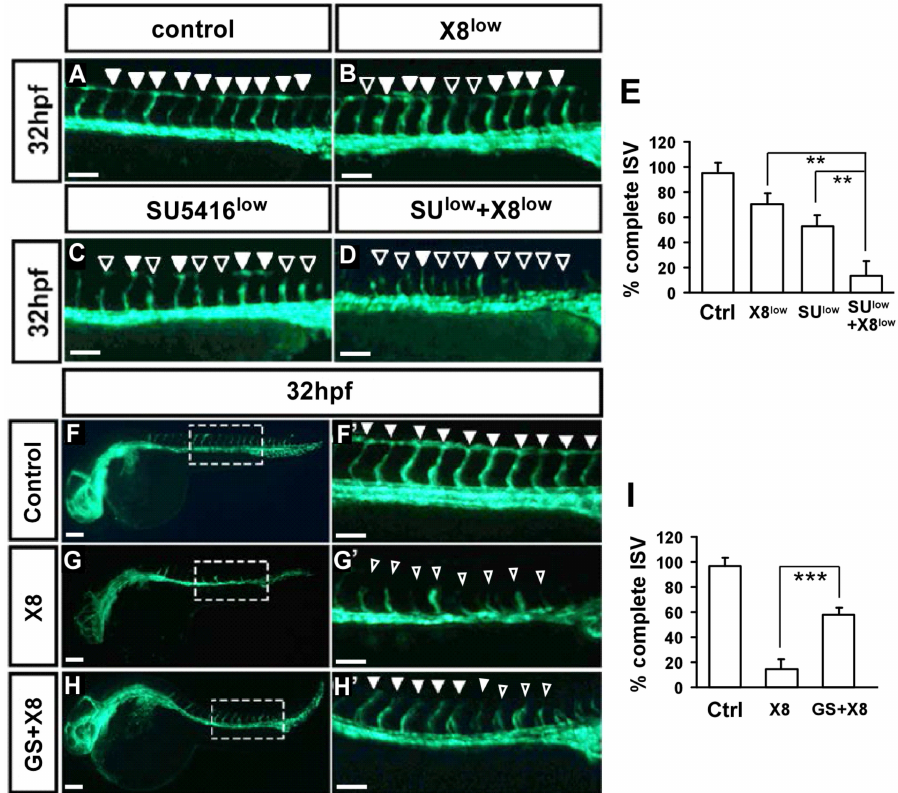
Figure 6. Interaction between X8 and VEGF signaling. ( A – E ) Enhanced effects of vascular defects in embryos cotreated with X8 and SU5416. At 32 hpf, in untreated control embryos ( A ), ISVs reached the DLAV ( arrowheads ). ISV growth was weakly affected in embryos treated with a lower concentration of X8 (1.5 µ M) ( B ) or a lower concentration of SU5416 (5 µ M) ( C ). Embryos treated with the combination of X8 and SU5416 showed enhanced vascular defects in ISV growth (hollow arrowheads in ( D )). ( E ) The quantitative analysis of ISV structures showed an enhanced reduction in X8- and SU5416- cotreated embryos (n = 20) at 32 hpf. ( F – H , F’ – H’ ) Rescue effect of the angiogenic compound GS4012 in X8-treated Tg(flk:egfp) zebrafish embryos. Embryos were treated with X8 (3 µ M) in combination with ( H , H’ ) or without ( G , G’ ) GS4012 (1 µ g/mL) at 6 hpf and were then imaged at 32 hpf. The percentage of complete ISV structures is quantified in ( I ). The data are presented as the mean ± SD values (n = 20). The asterisks indicate statistical significance versus control embryos. ** p < 0.001 and *** p < 0.0001 by unpaired Student’s t -test. Scale bars: 100 µ m in ( A – D , F’ – H’ ); 200 µ m in ( F – H